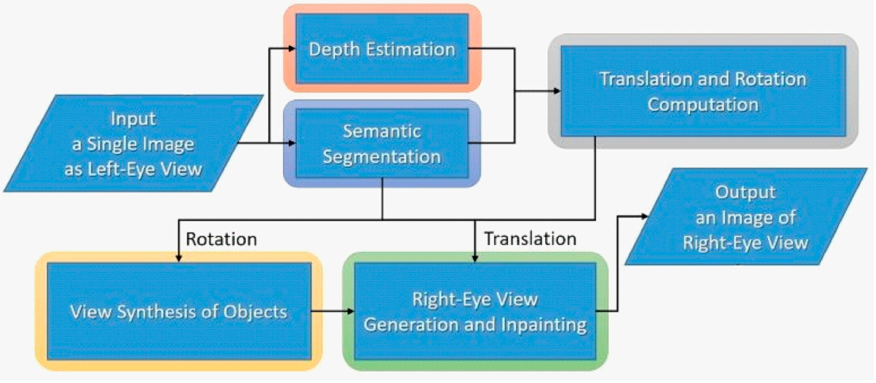
Figure 1. Flowchart of our model.